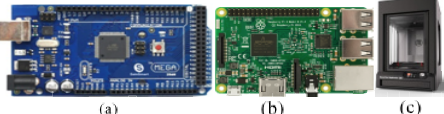
Fig. 4. Available equipment at Makerspace used for prototyping (a) Arduino Mega, (b) Rasp- berryPi 3, (c) MakerBot